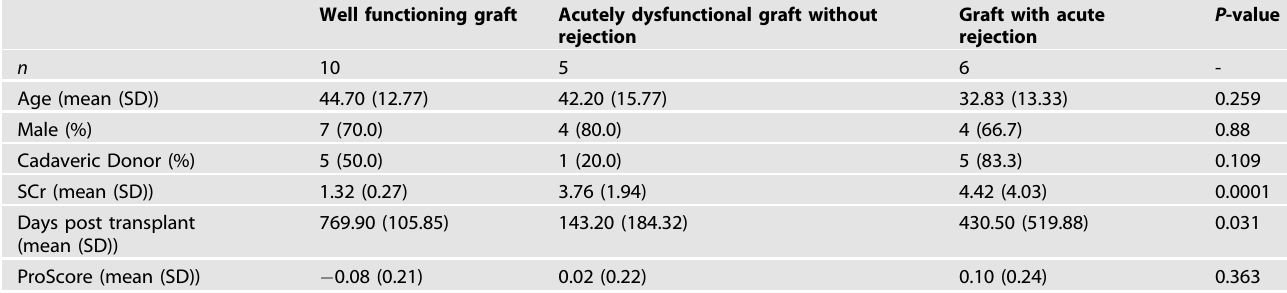
Table 2. Baseline characteristics of the patient taken into WGCNA.